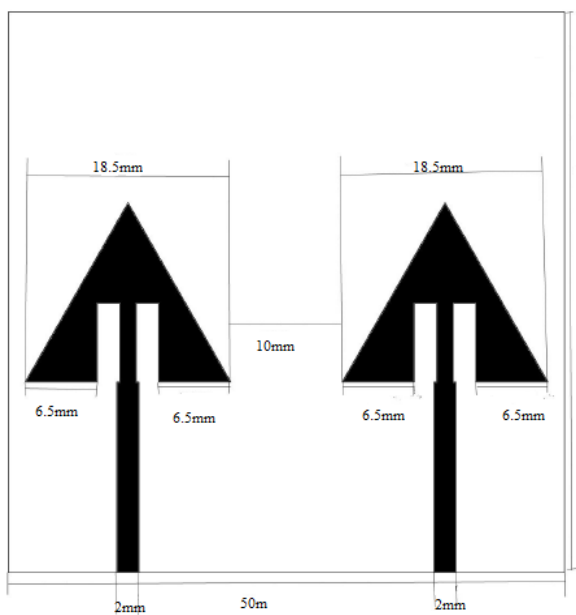
Figure 1: Geometry of the MIMO CSRR loaded patch antenna (a) top view